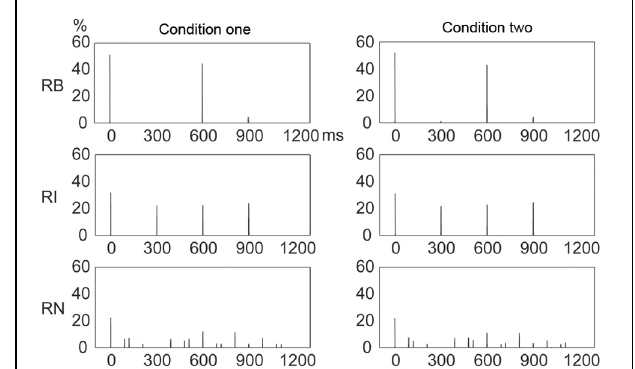
FIGURE 10 | Frequency distributions of incorrectly reproduced events in a beat interval. The frequency distribution of incorrectly reproduced events was highly similar to that of presented events ( Figure 4 ) for all rhythm types in both conditions. Y axis: percent of occurrences of incorrectly reproduced events. X axis: positions with the occurrence of incorrectly reproduced events in a beat interval 1200ms in duration. RB, RI, and RN represent rhythms formed with binary, non-binary integer, and non-integer ratios,